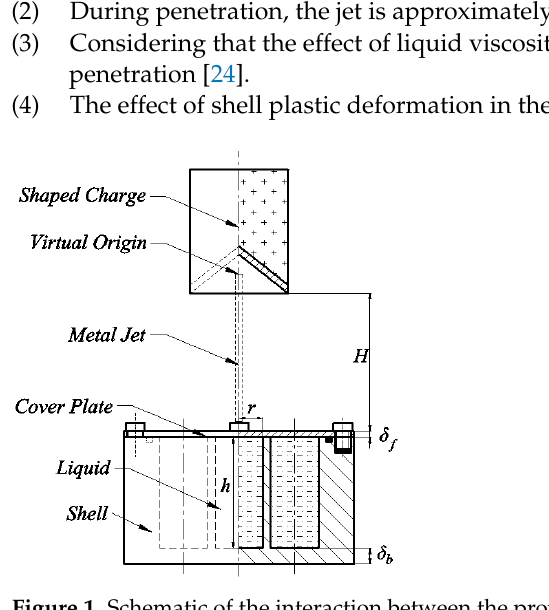
Figure 1. Schematic of the interaction between the projectile and the target.